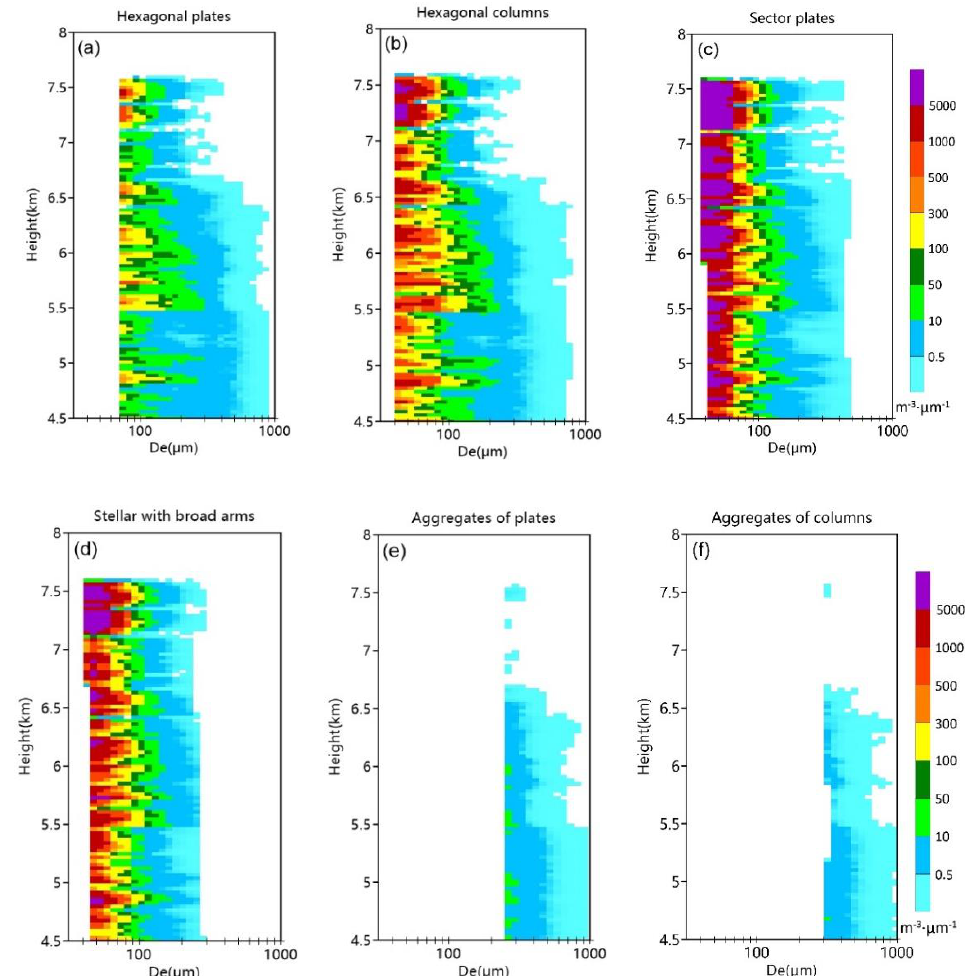
Figure 7. Retrieved PSDs at different heights for six ice crystal types—hexagonal plates ( a ), hexagonal columns ( b ), sector plates ( c ), stellar plates with broad arms ( d ), aggregates of plates ( e ), and aggregates of columns ( f ).